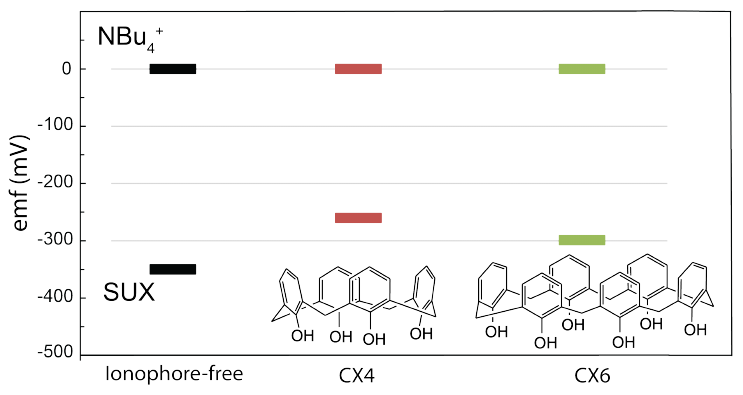
Figure 4. The differences in the emf of the SUX ISE for 10 mM SUX solution with respect to 10 mM Bu 4 N + (black trace shows an ionophore-free sensing membrane, red trace shows the CX4 ionophore in the sensing membrane, and the green trace shows the CX6 ionophore in the sensing